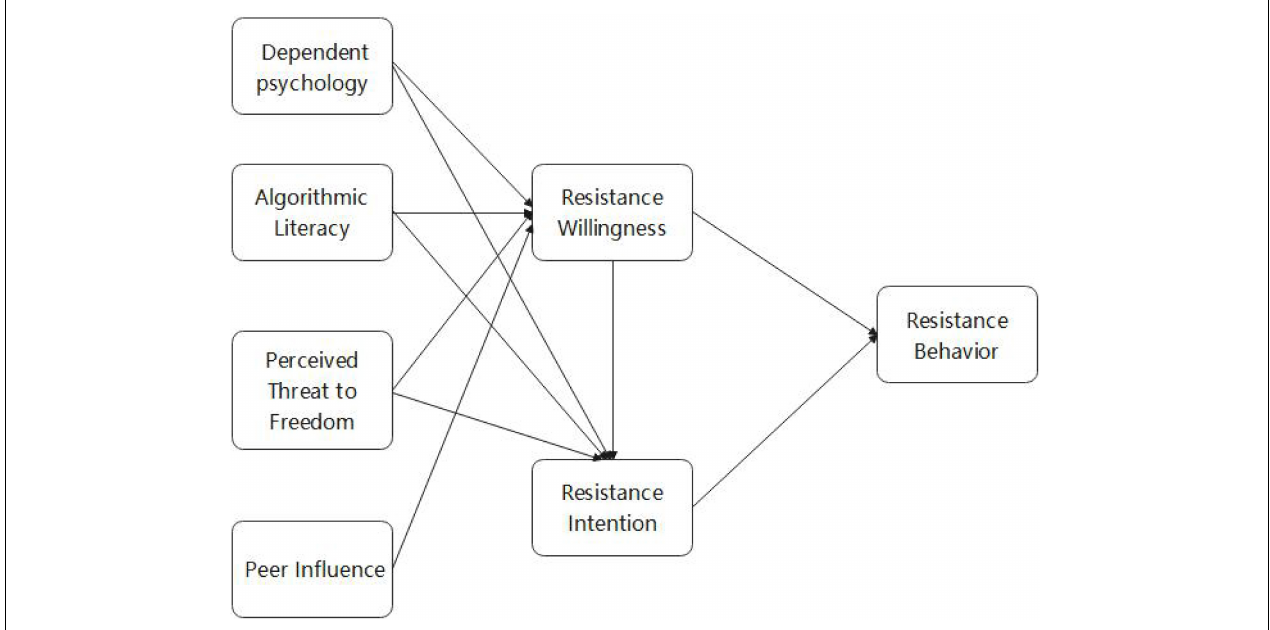
FIGURE 1 | Conceptual